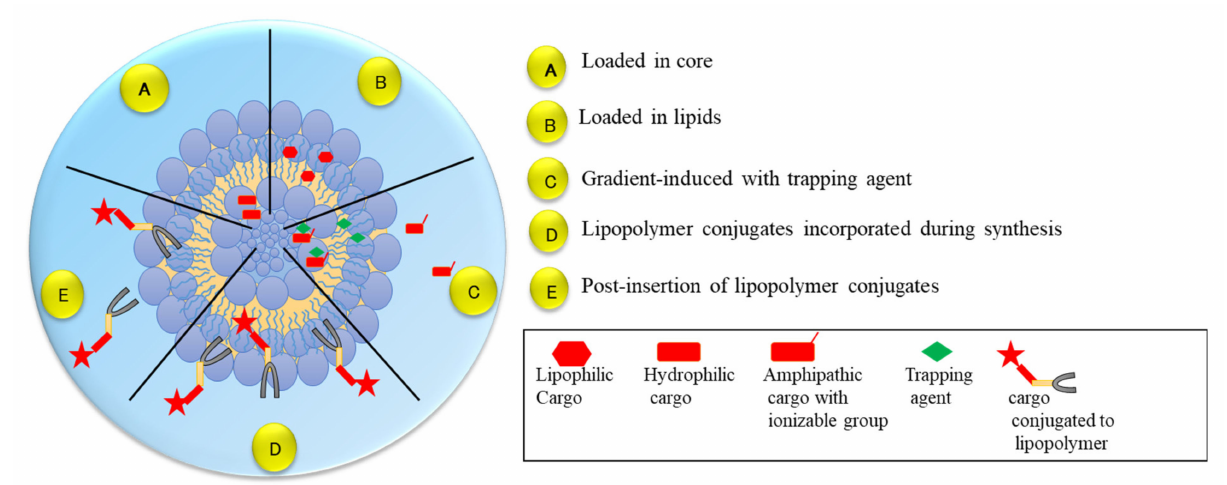
Figure 3. Illustartion of bioconjugated lipid-based nanoparticles for drug